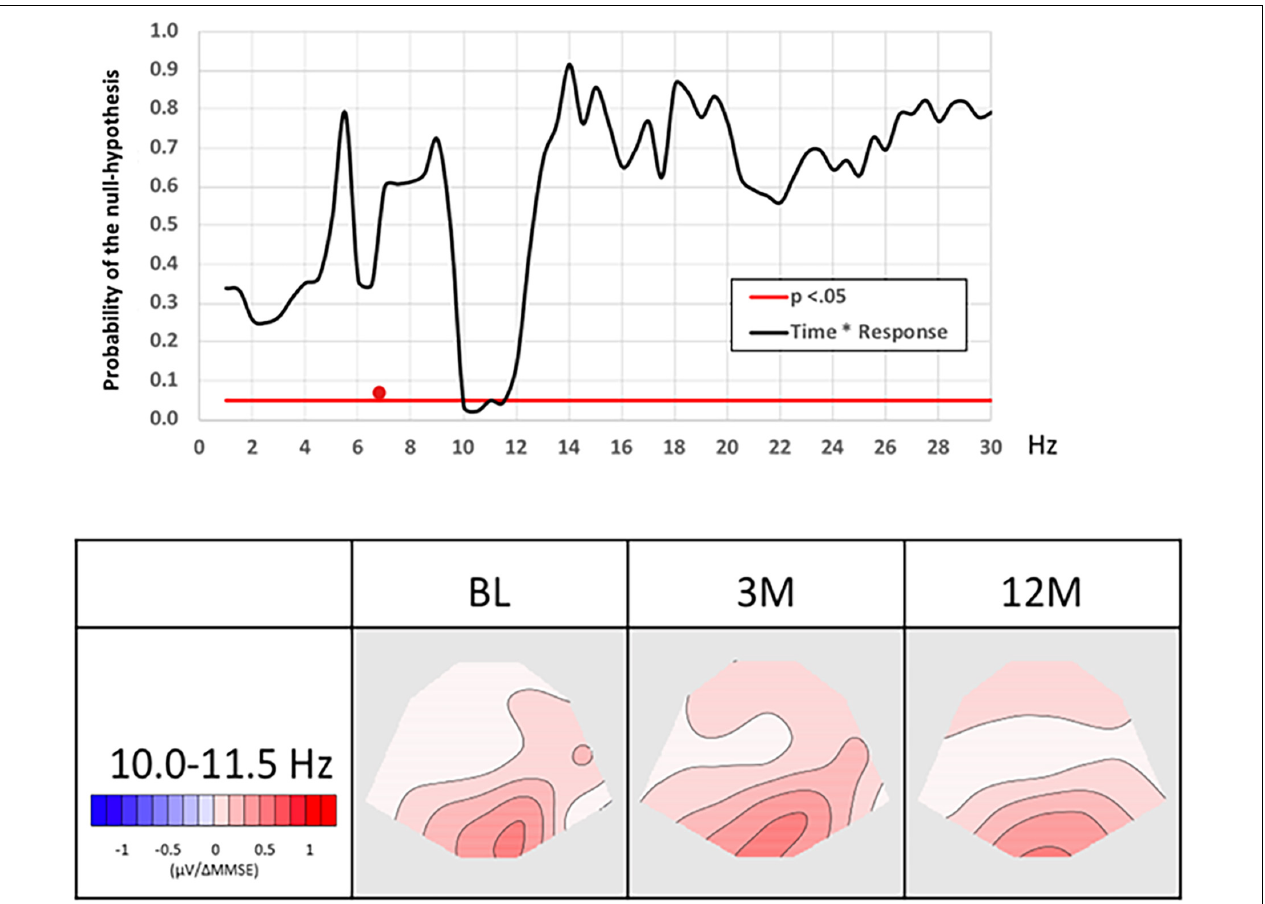
FIGURE 2 | Association between MMSE and EEG spectral power as a function of time. The graph on the left the probability (p) of the null hypothesis ( y -axis) for the TANCOVA interaction between time and MMSE change as a function of frequency in Hz ( x -axis). Significant ( p < 0.05) frequency range is marked by a white line shows. The red cursor marks the frequency range represented by the covariance maps. Topographic maps display topographic covariance of the EEG spectral power correlating to MMSE changes at the frequency range 10–11.5 Hz for the three EEG recording occasions. Red maps show were less than the average change in MMSE score related to an increase in alpha frequency. BL, baseline; EEG, electroencephalography; MMSE, mini-mental state examination; TANCOVA, topographic analysis of covariance, 3 m: 3 months, 12 m: 12